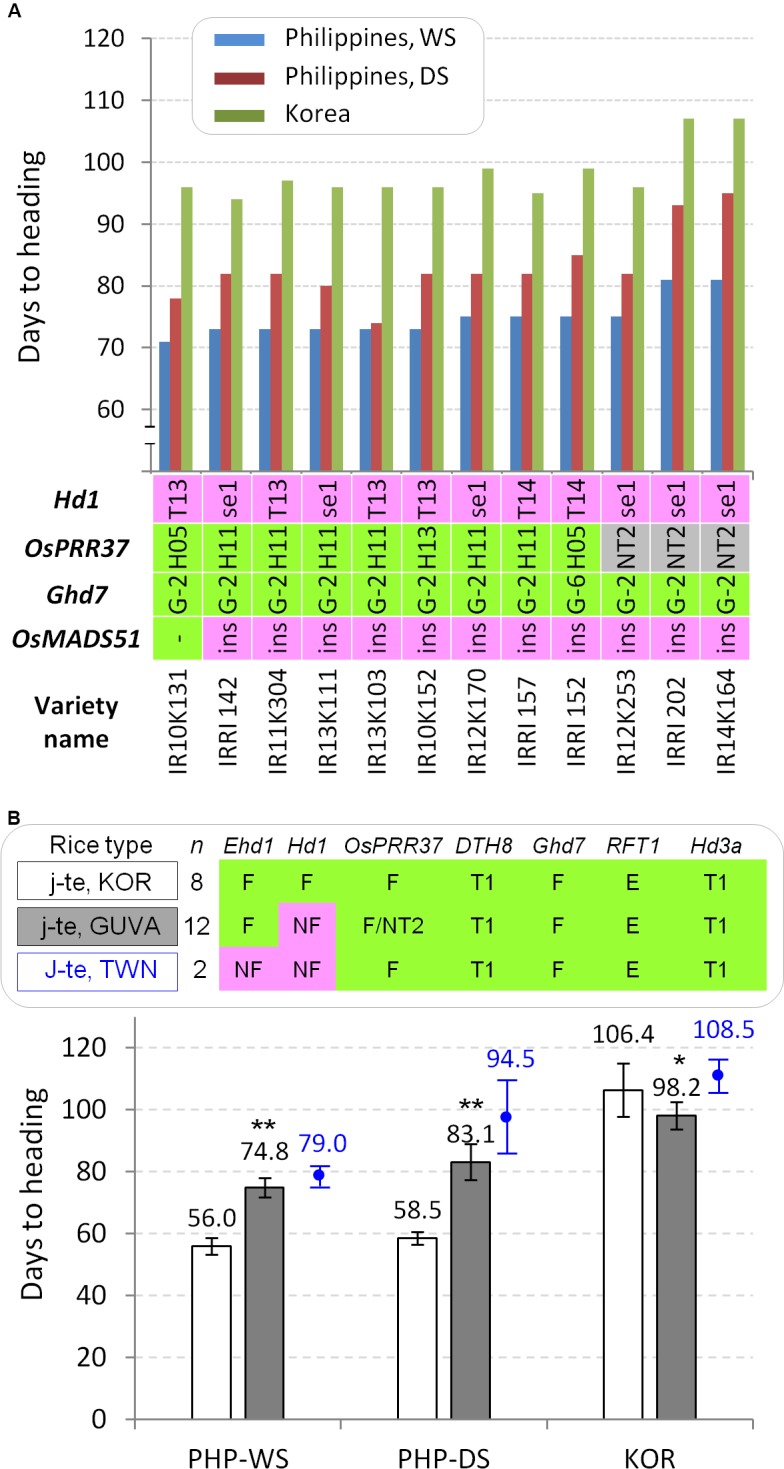
The 12 GUVA temperate japonica lines adapted to the tropics. (A) DTH and allele types of each flowering gene. Varieties/lines are sorted by DTH at the IRRI in the wet season. All 12 lines have DTH8-Type 1, functional Ehd1, functional RFT1, and Hd3a-Type 1 alleles. (B) Comparison of DTH between Korean temperate japonica varieties (j-te, KOR) and the 12 tropical zone-adapted temperate japonica varieties (j-te, GUVA) in three environmental conditions. Student’s t-test (∗
α = 0.05 and ∗∗
α = 0.01). As references, two Taiwanese temperate japonica varieties Taichung 65 and Tainung 67 (j-te, TWN) were presented (labeled by blue color).